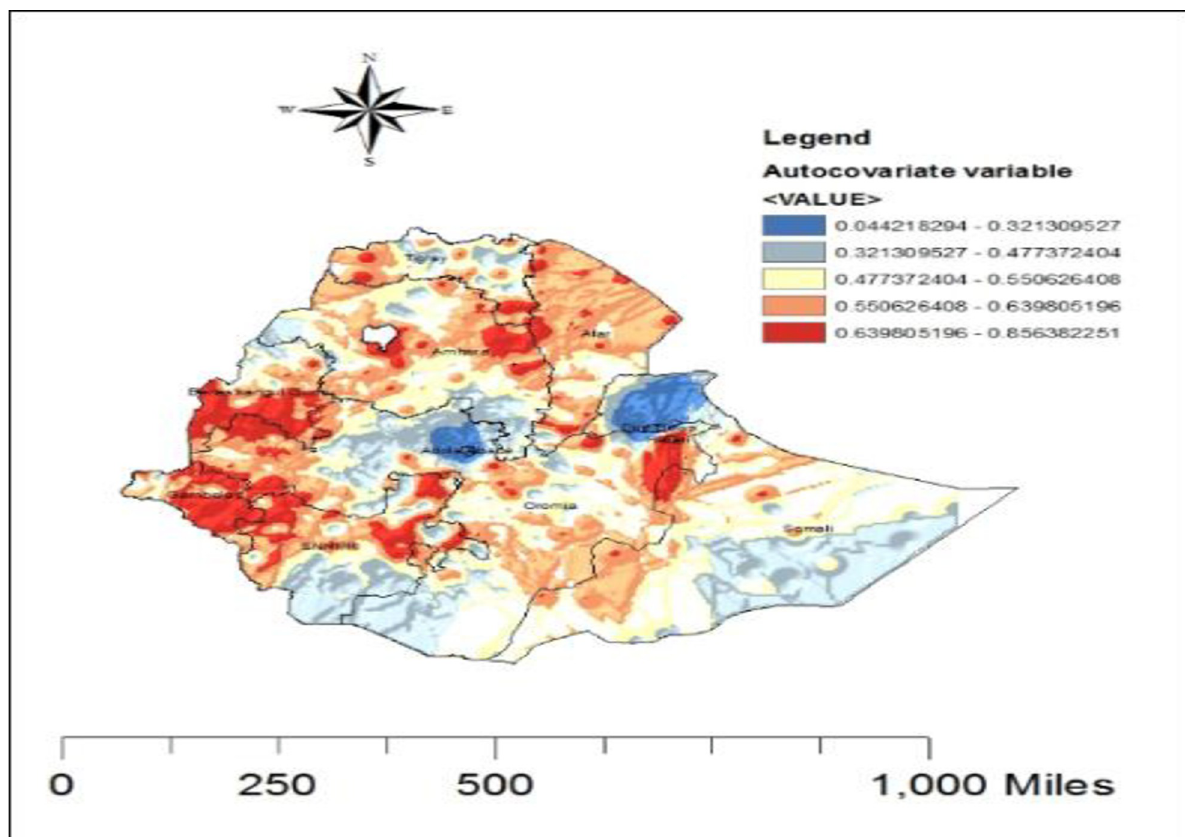
Fig 4. Predicted spatial effects from the malaria case in Ethiopia, from EMIS